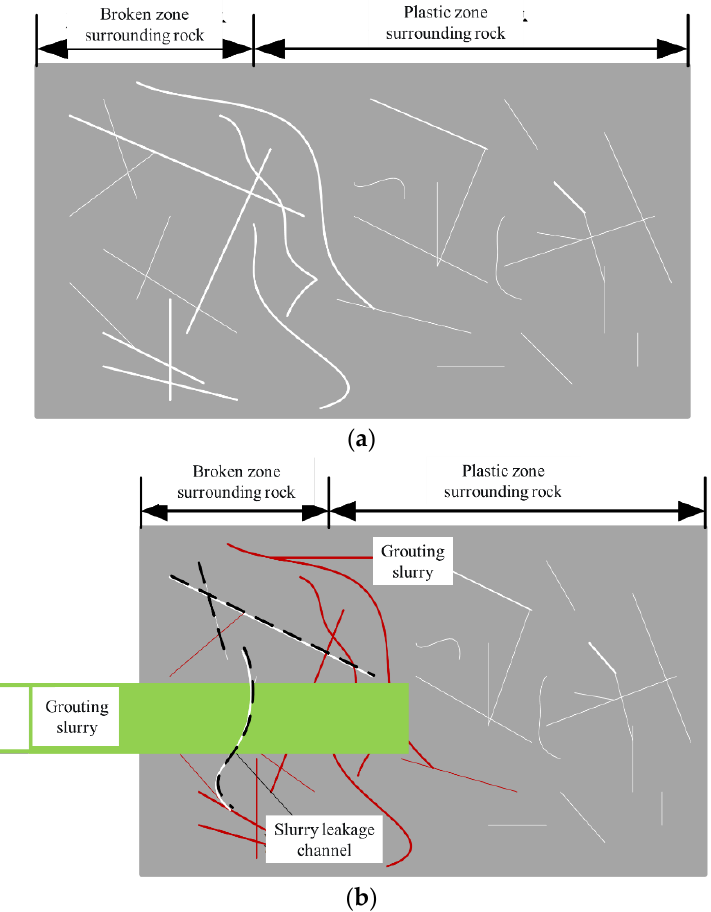
Figure 6. chematic diagram of traditional grouting [28]. ( a ) Without grouting in surrounding rock; ( b ) traditional grouting in surrounding rock.